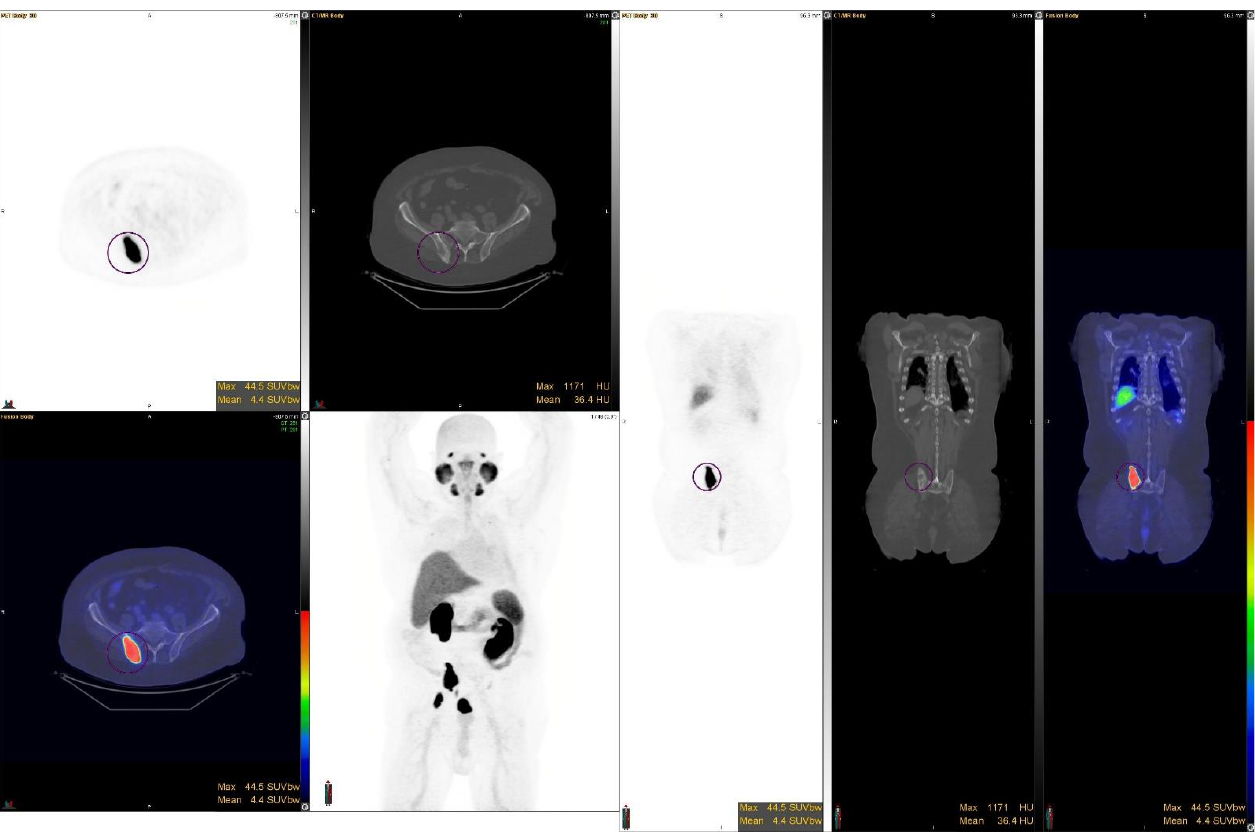
Figure 2. F-18 Pyl PSMA PET/CT demonstrates the distribution of PCa metastasis at pelvic bones .